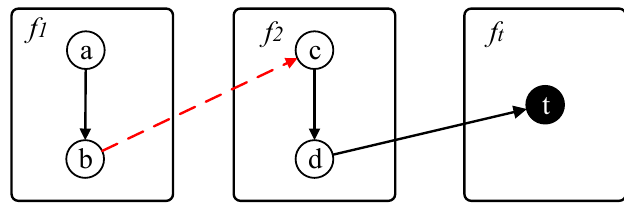
Figure 6. Example of updating the distance